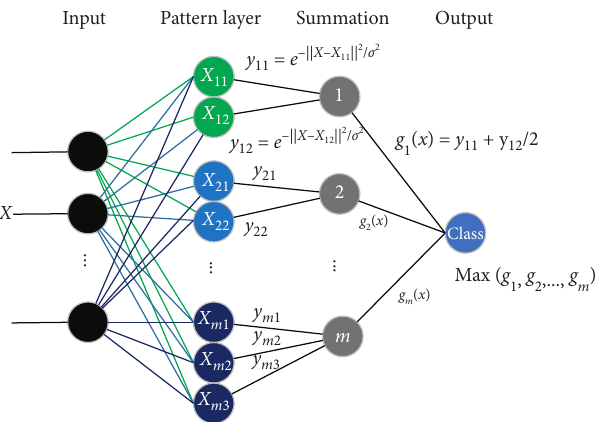
Figure 7: Probabilistic neural network